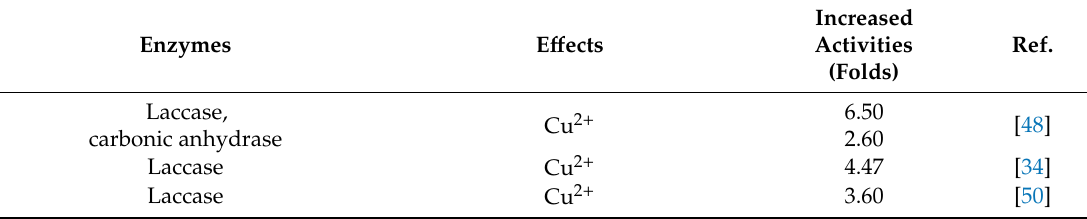
Increased (Folds)